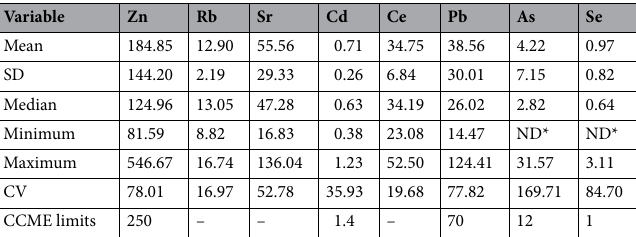
Table 2. Descriptive statistics of the soil heavy metal concentrations at 15–30 cm in Guelph community gardens (in ppm). * ND